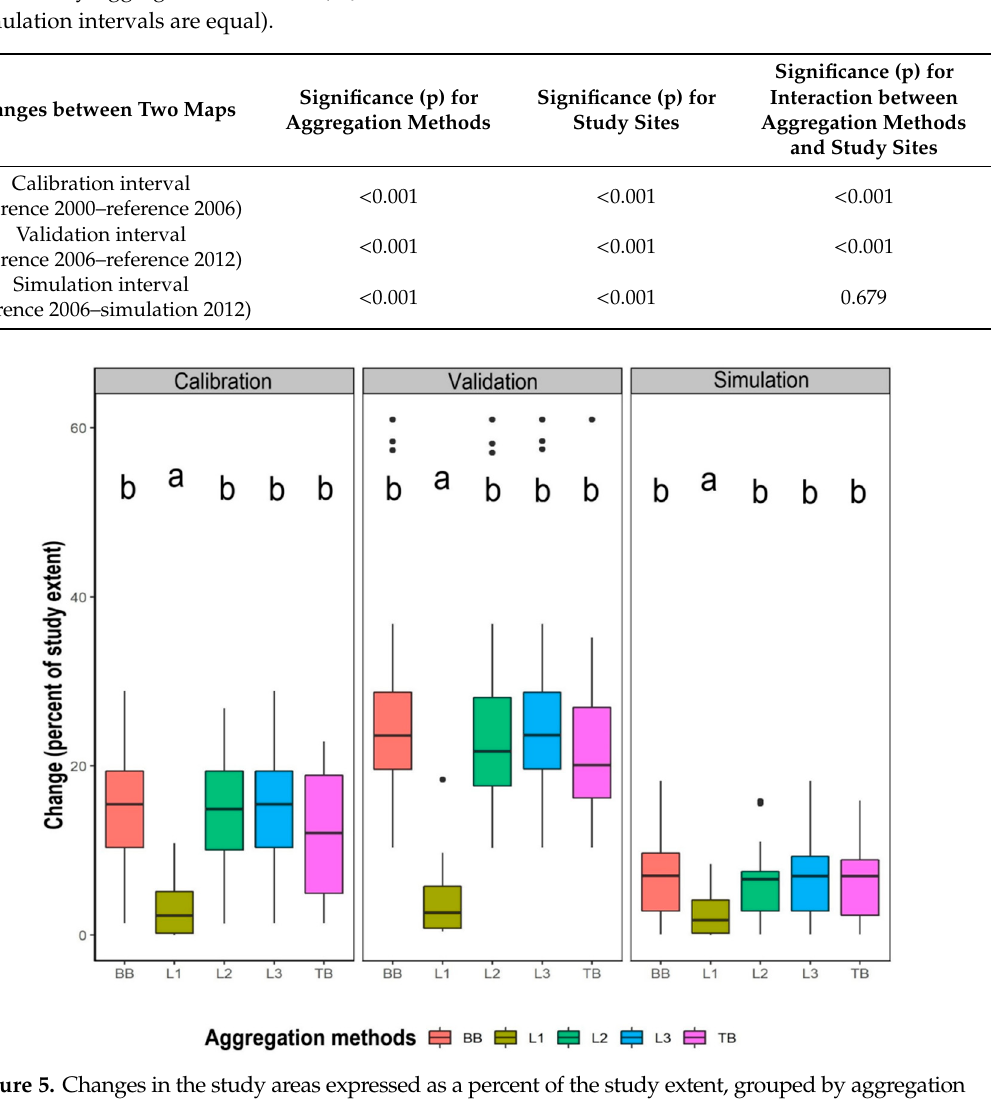
Figure 5. Changes in the study areas expressed as a percent of the study extent, grouped by aggregation method (A) reference change during 2000–2006 (B) reference change during 2006–2012 and (C) simulated change during 2006–2012. The groups for which the medians are not significantly different are assigned a common letter. (BB = Behavior-based aggregation; L1 = Corine Standard Level 1 aggregation; L2 = Corine Standard Level 2 aggregation; L3 = Corine Standard Level 3 aggregation). BB, L1, L2, L3 and TB groups include 24,24,24,24 and 18 model runs, respectively. The vertical middle line shows the median, the box boundaries show the first and third quartiles of the group, the lower and upper end of whiskers show the minimum and maximum values that are not outliers, while the points show the outliers.